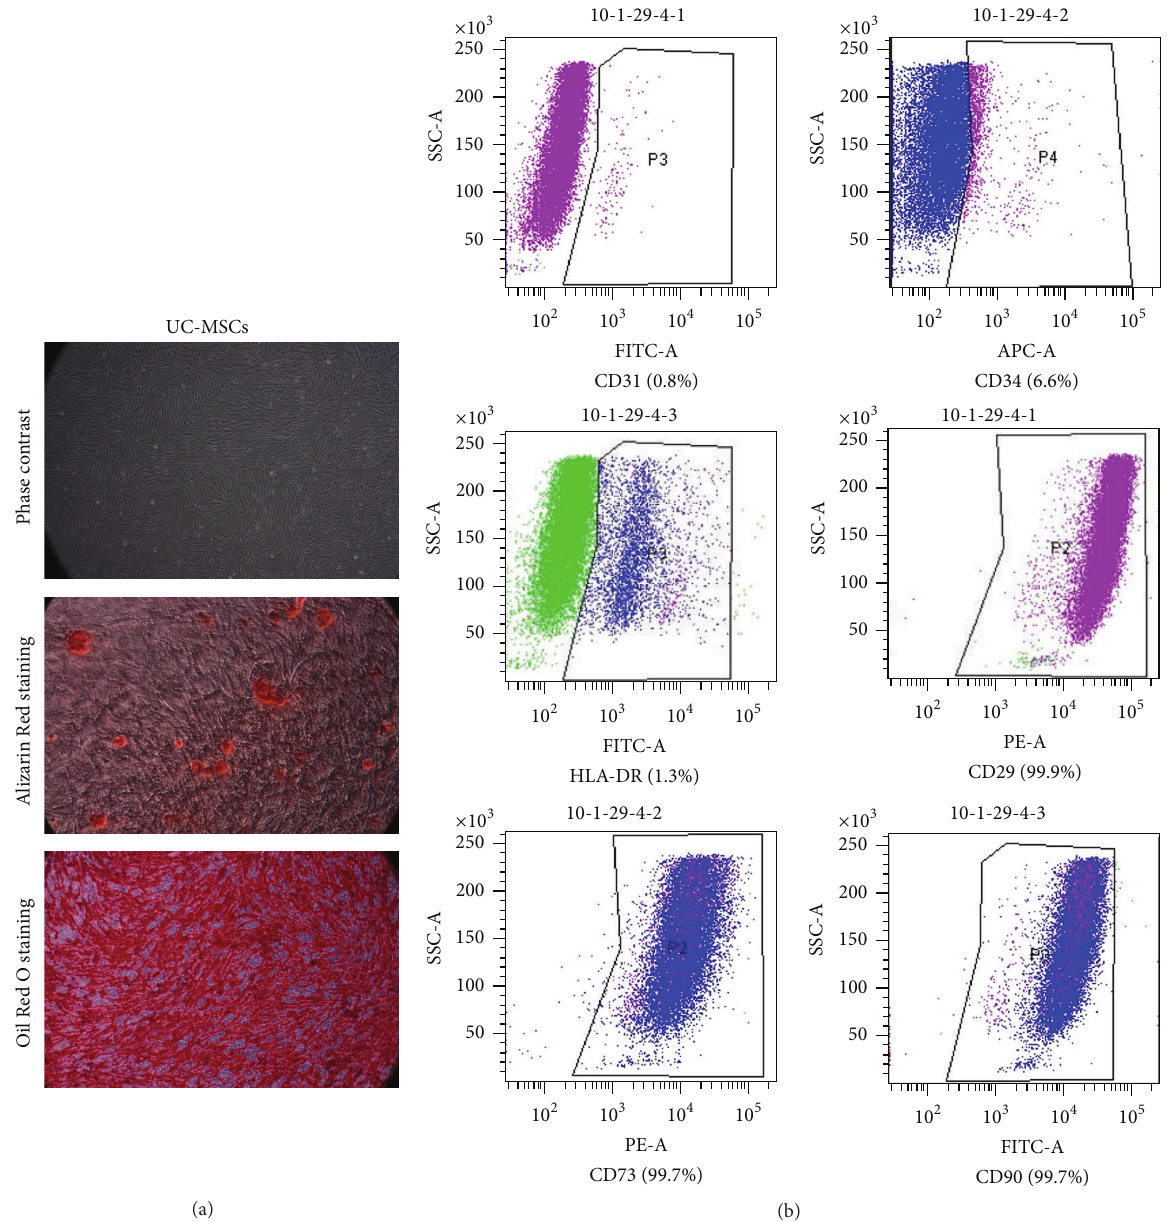
Figure 2: Verification with MSC characters. MSCs were isolated from human umbilical cord materials. Isolated cells displayed fibroblast-like morphology on the plastic surface and were positive for Alizarin Red staining and Oil Red O staining (a). At the same time, isolated cells were analyzed with MSC specific markers by FACS and cells were positive for CD29, CD73, and CD90 but negative for CD31, CD34, and HLA-DR